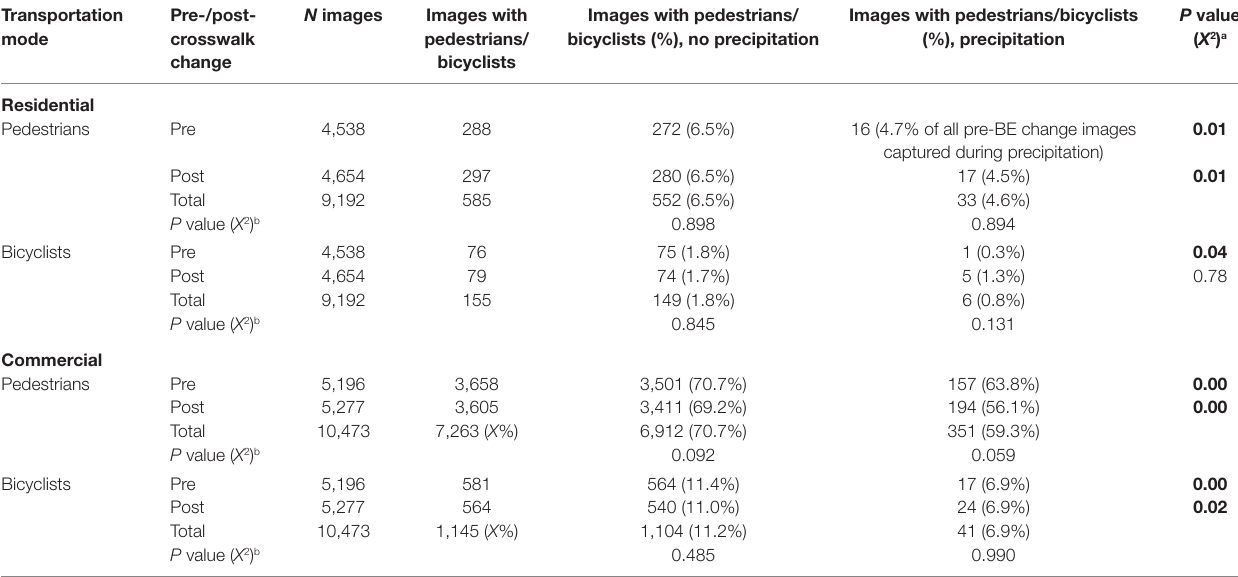
TaBle 4 | images with pedestrians and bicyclists before and after crosswalk enhancement, with and without precipitation. Transportation